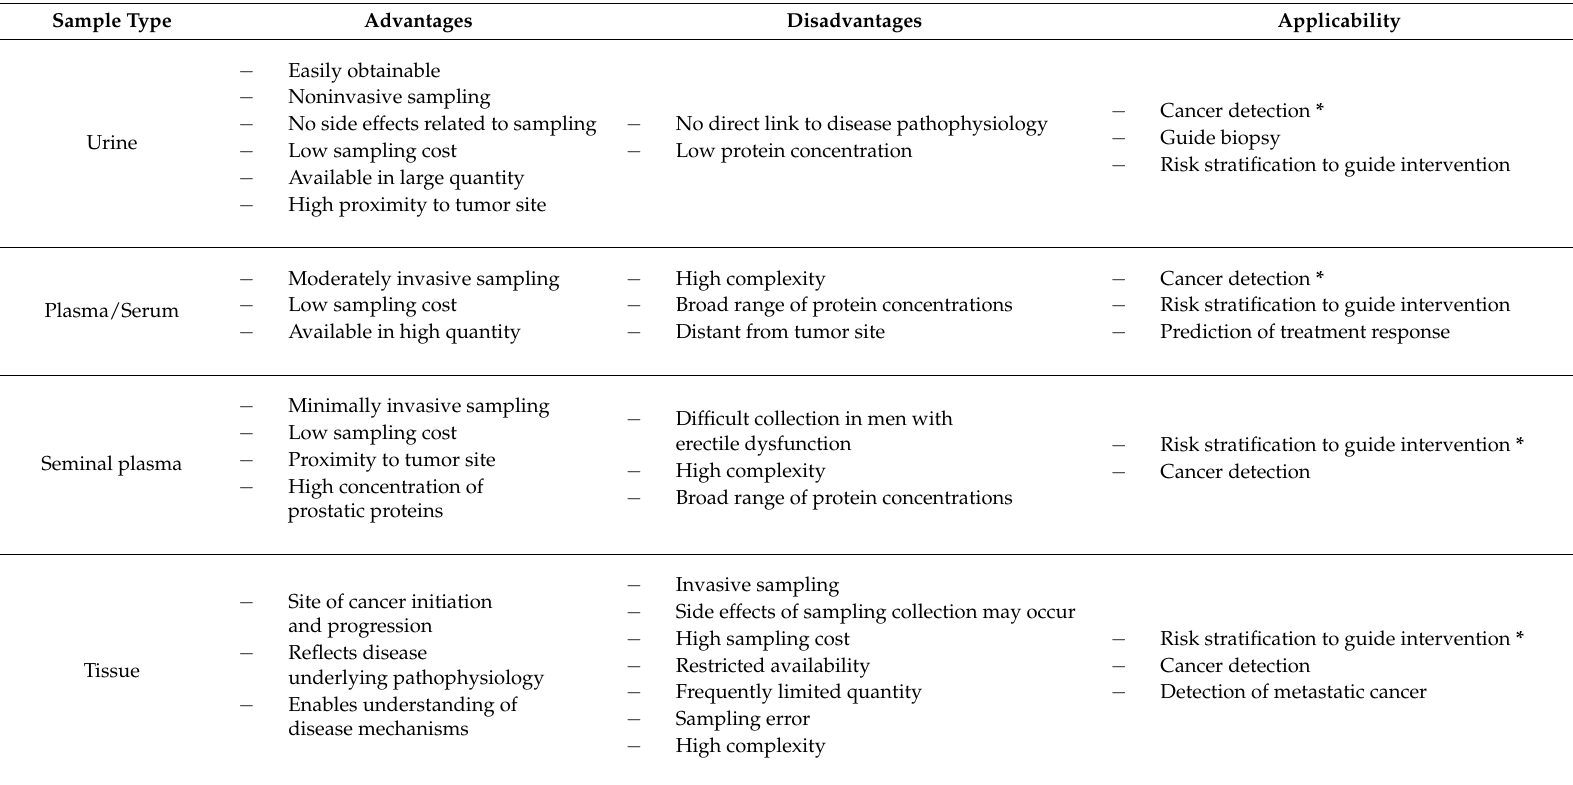
Table 2. Summary of clinical samples applied in prostate cancer biomarker